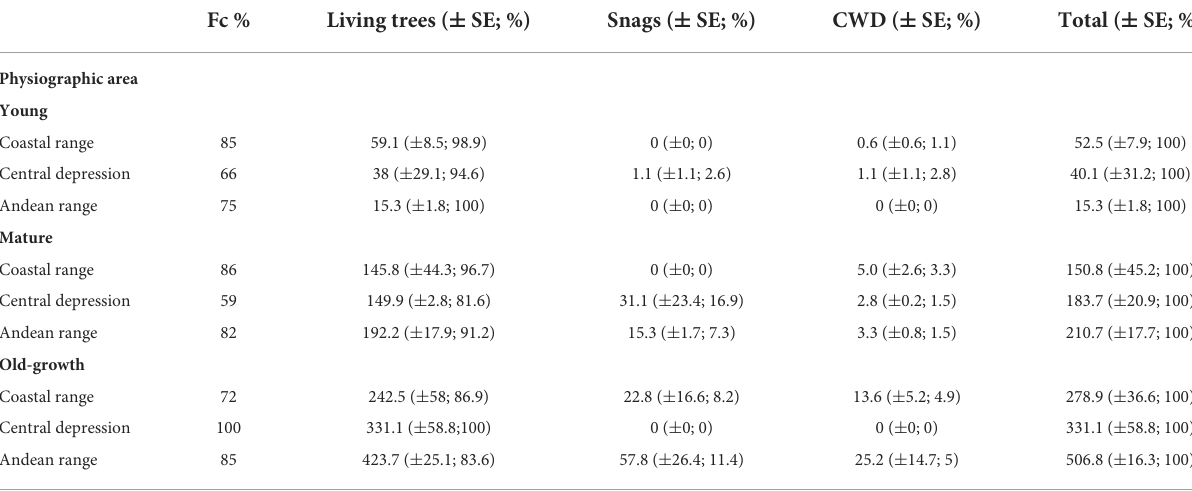
TABLE 1 Mean carbon stocks for the different physiographic units, stand development stages, and carbon pools (Mg C ha − 1 ). Fc % Living trees ( ± SE; %) Snags ( ± SE; %) CWD ( ± SE; %) Total ( ± SE;